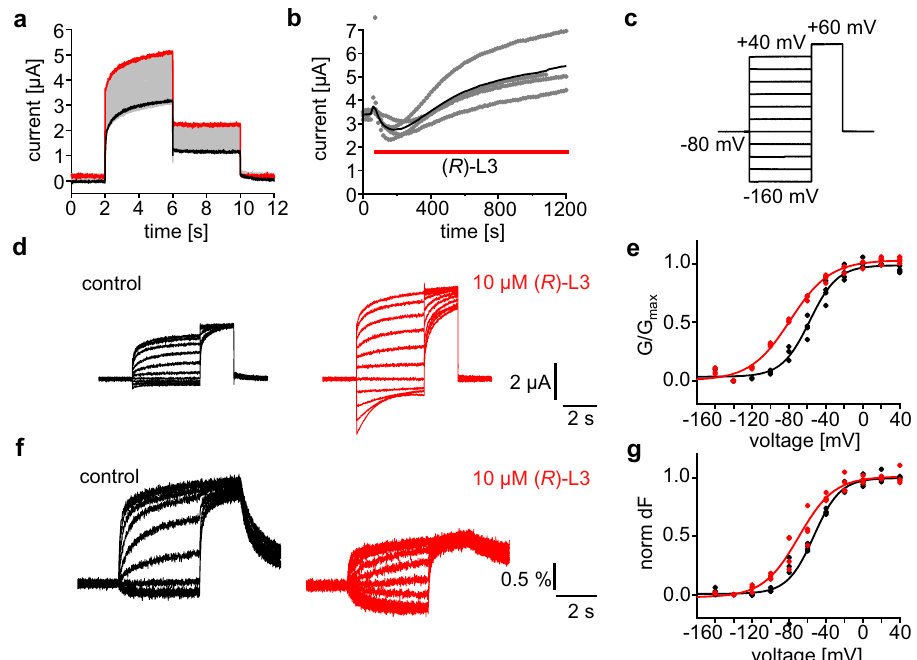
Fig. 3 ( R )-L3 potentiates K v 7.1 VCF (C214A/G219C/C331A) currents and left shifts the voltage-dependence of G / G max and dF/F. a Whole-cell currents from an oocyte expressing K v 7.1 VCF labeled with Alexa 488 C5 maleimide. Every 15 s, the membrane voltage was pulsed from the − 80 mV resting potential to + 60 mV for 4 s, followed by 2 s tails at − 40 mV. Currents before (black) and after (red) a bolus of ( R )-L3 was added to the bath ( fi nal concentration ~10 μ M). b Steady-state current at + 60 mV versus time during application of ( R )-L3 (indicated by red bar). Blackline represents the mean value, gray dots represent raw data from each measurement ( n = 4). c Pulse protocol for simultaneous current and fl uorescence recordings in ( d - g ). d Sample current trace from a single oocyte before (black) and after (red) exposure to ~10 μ M ( R )-L3. e G / G max voltage relationship of K v 7.1 VCF expressing oocytes in the absence (black) and presence (red) of ( R )-L3 ( n = 4 for both conditions). f Sample fl uorescence trace from an oocyte before (black) and after (red) exposure